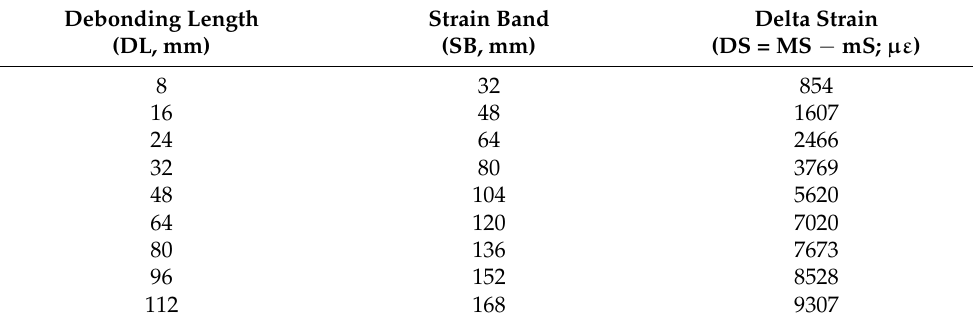
Figure 13. Strain variation (με) characteristic parameter, related to arrays differently deployed. Table 4. Characteristic parameters vs. debonding